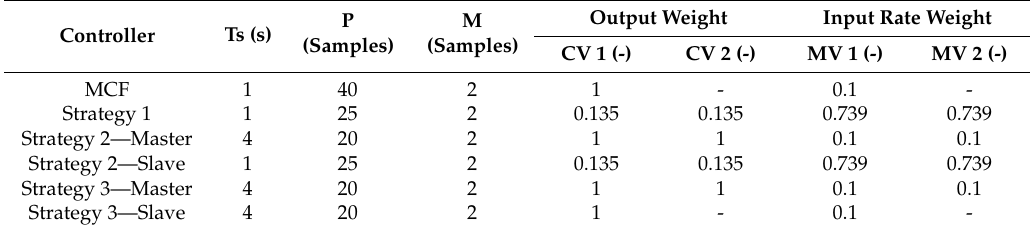
Table 4. MPC tuning